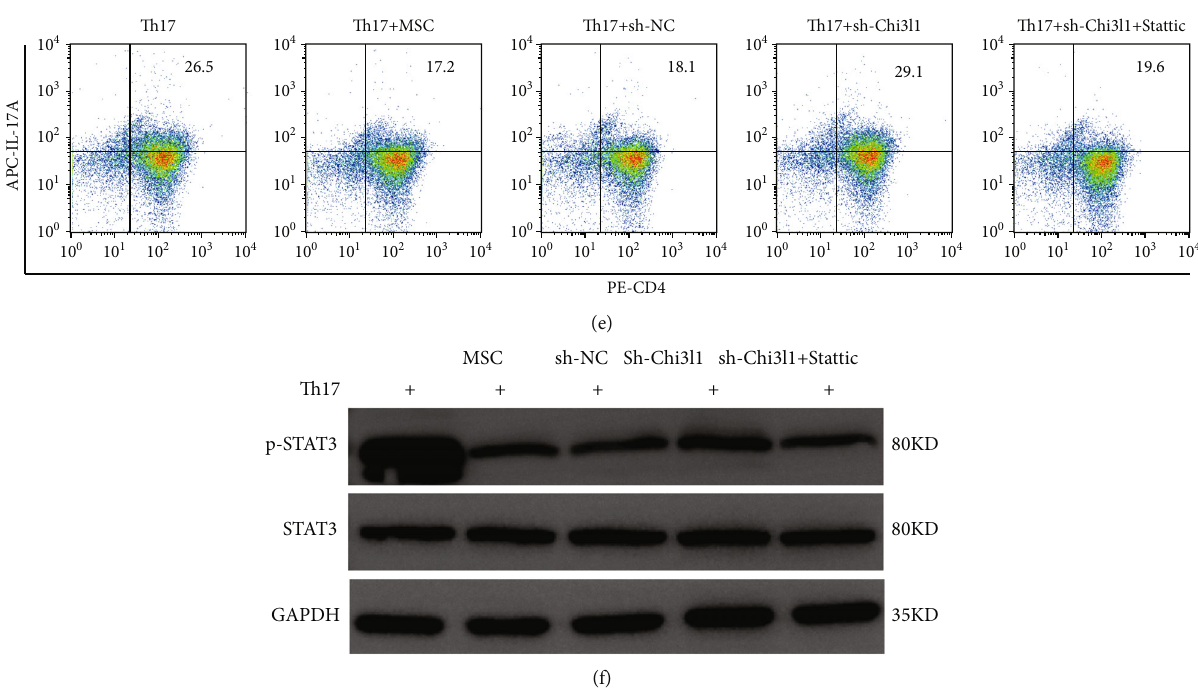
Figure 7: hUC-MSC-secreted Chi3l1 represses CD4 di ff erentiation to Th17 cells by inhibiting STAT3 activation. (a) Reactome pathway showing that Chi3l1 is associated with interleukin-6 family signaling. (b) Gene Ontology showing that Chi3l1 is associated with lymphocyte di ff erentiation. (c) STRING interaction network displaying that Chi3l1 interacts with STAT3. (d – f) CD4 + T cells ( 5 × 10 5 ) obtained from the spleen of C57BL/6J mice were di ff erentiated into Th17 cells in 96-well plates in the presence or absence of hUC- MSCs, sh-NC-MSCs, sh-Chi3l1-MSCs, or sh-Chi3l1-MSCs ( 5 × 10 3 ) plus Stattic (20 μ M) at a CD4 + T/hUC-MSC ratio of 100:1 for 72 hours. (e) The proportion of Th17 cells was analyzed using fl ow cytometry. (d) The percentage of Th17-positive cells was detected by fl ow cytometry (one-way ANOVA and Tukey ’ s multiple comparison test, ∗ P < 0 : 05 , three independent experiments). (f) Protein expression level of p-STAT3 measured by western blot. STAT3: signal transducer and activator of transcription 3; sh-NC: sh-NC-MSCs; sh-Chi3l1: sh-Chi3l1-MSCs. Stattic: p-STAT3